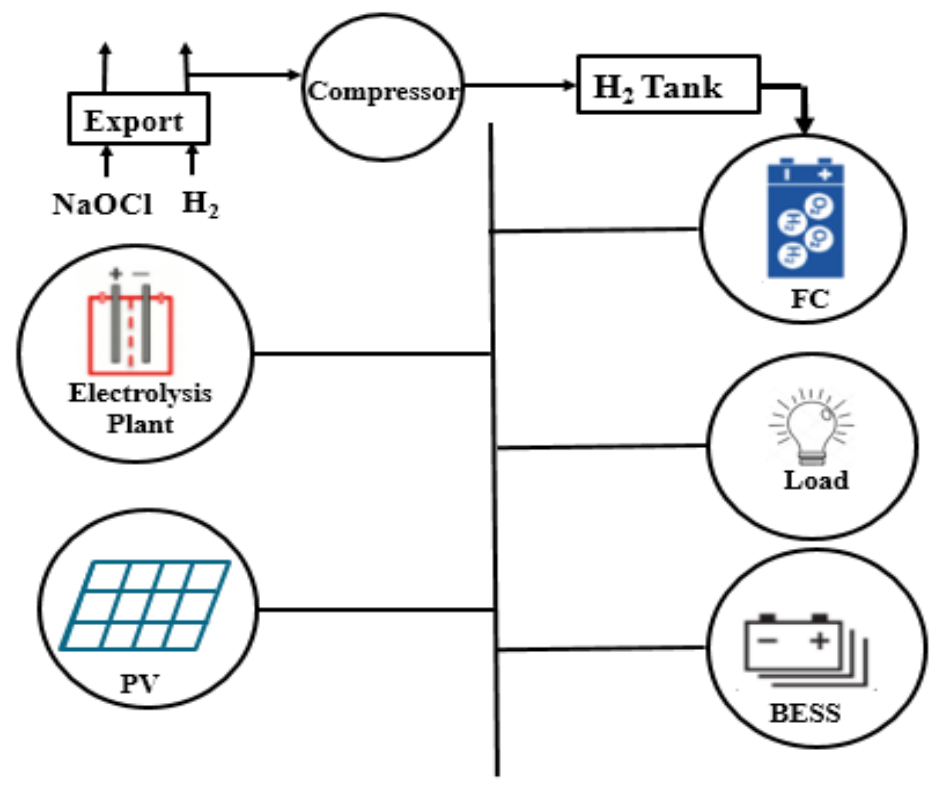
Figure 3. Proposed power system